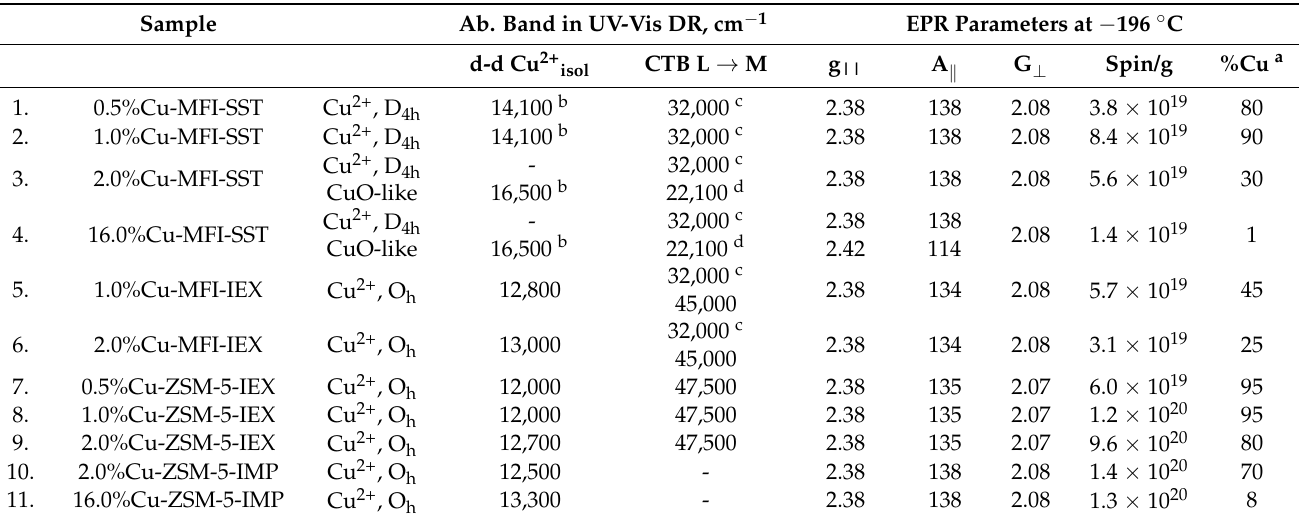
Table 3. The main electronic state of Cu-ions in Cu-containing zeolites prepared by different methods and their UV-Vis DR and EPR